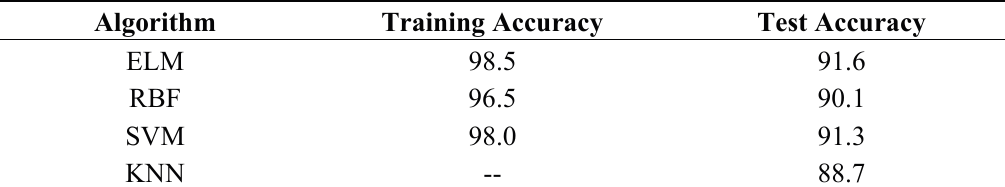
Table 1. Accuracy comparison of different classifiers (%).